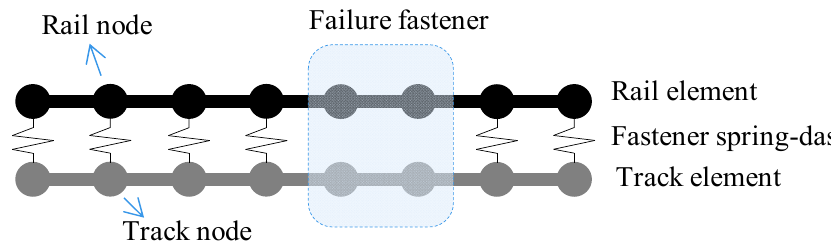
Figure 1. Rail–slab system considering fastener failure.